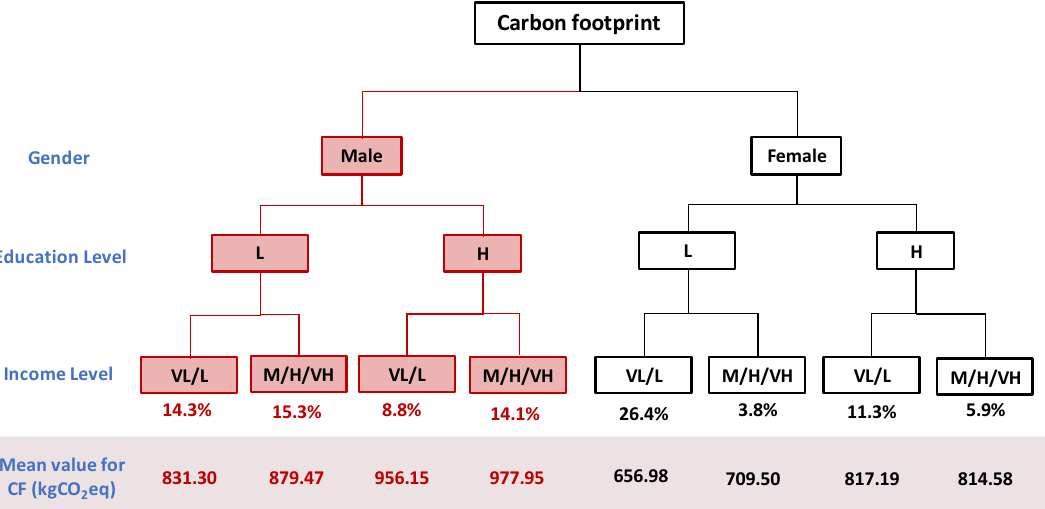
Figure 6. A decision tree for judgment of the carbon footprint consumption tendency where the red color indicates a high consumption tendency. The percentage under the decision tree represents the percentage of the number of samples under the category to the total number of samples. The real number indicates the average carbon footprint of 8 groups of people (kgCO 2 eq per year). For income level, VL, L and M mean very low, low and middle income level respectively, while H and VH mean high and very high income level. For education level, L and H mean low and high education level respectively.